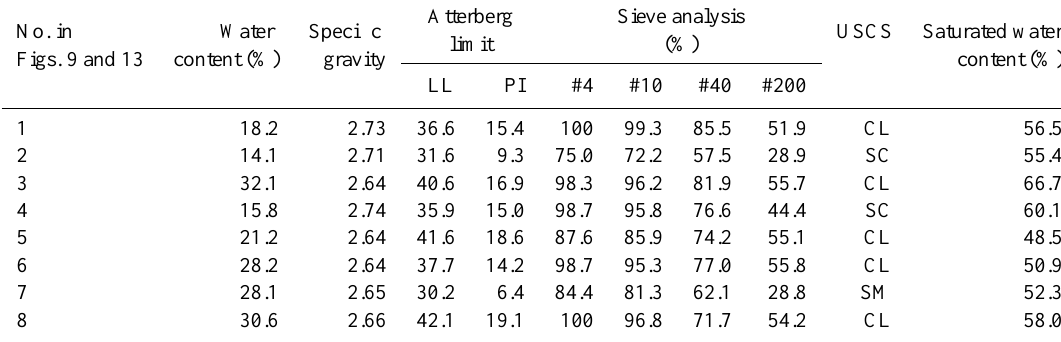
USCS Saturated water content (%)